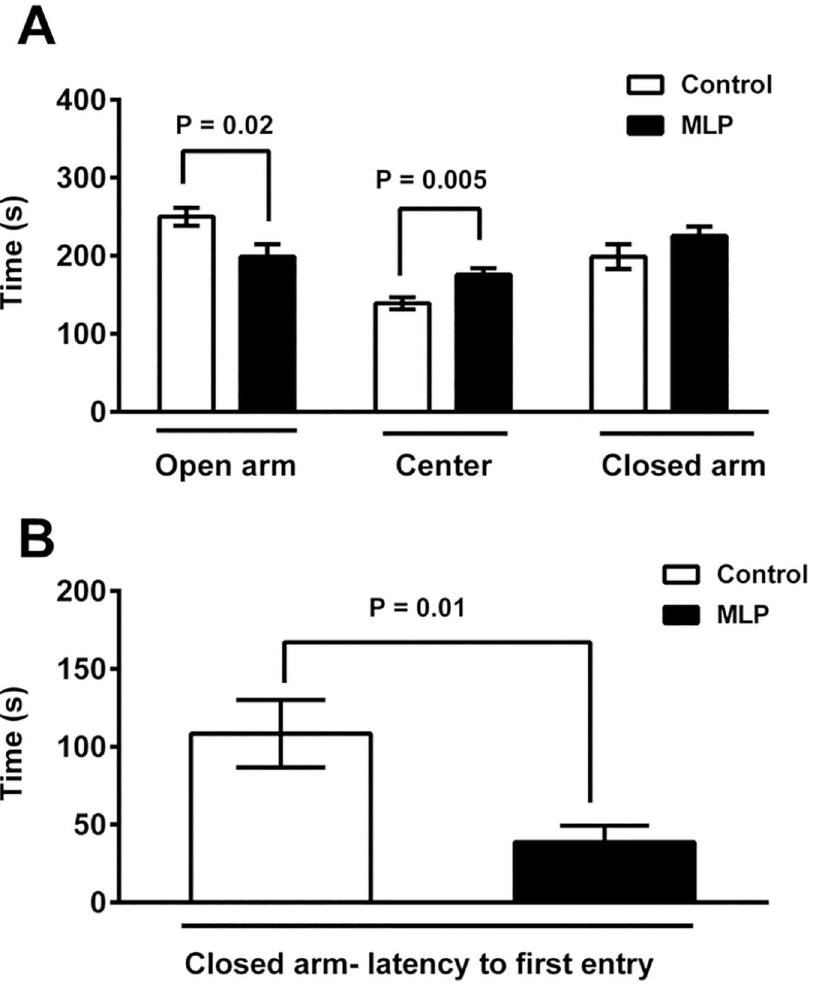
Fig 4. MLP male offspring mice display anxiety-like but not depression-like behavior. Elevatedplus maze test (MLP and Control, n = 9 each); (A) Time spent in open arm, center and closed arm, (B) Latencyto enter closed arm. (C) Tail suspensiontest (MLP, n = 31 and Control, n = 13) and (D) Forced swim test (MLP and Control, n = 20 each). Data is presented as mean ± SEM. P < 0.05 was considered statistically significant by student